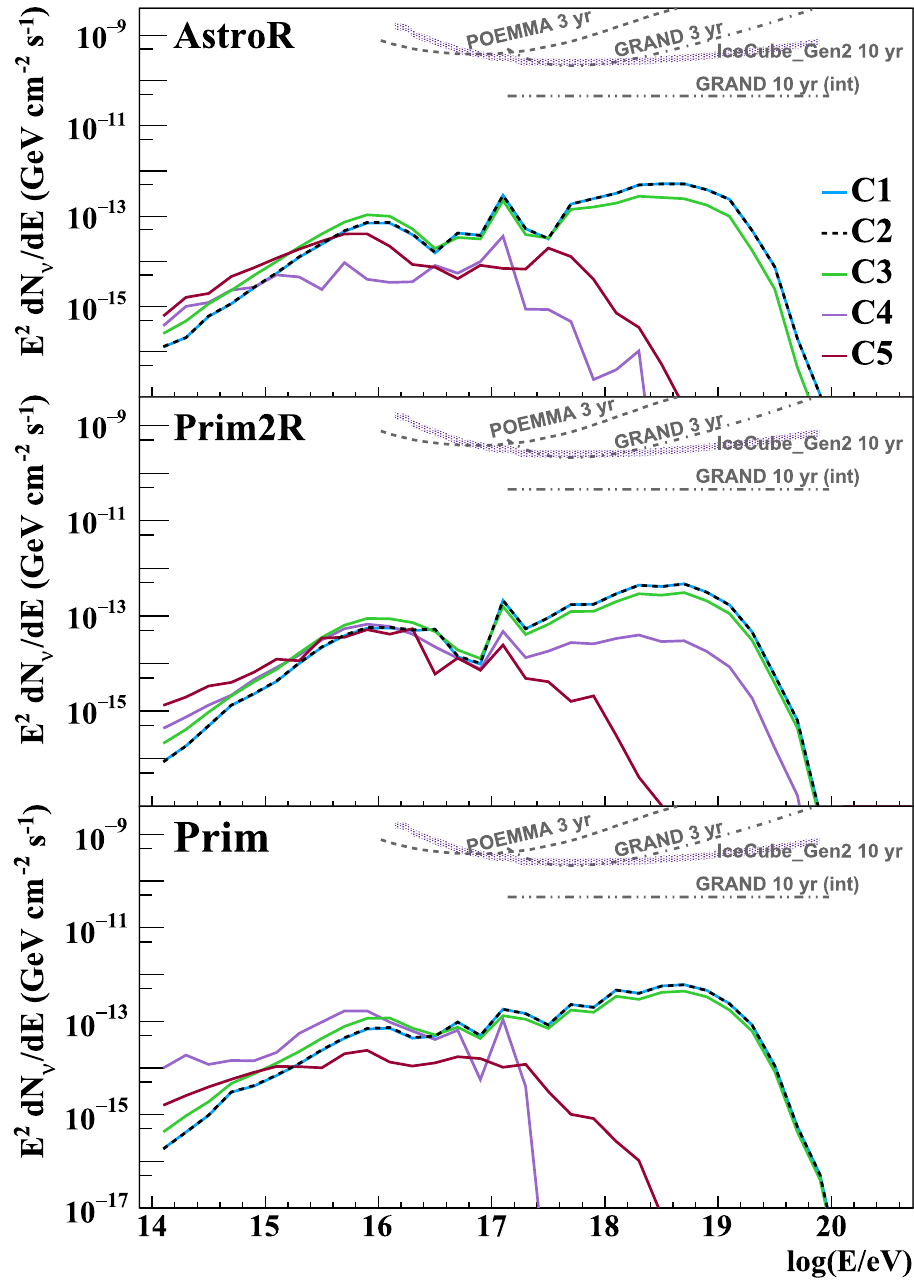
Fig. 4 Flux of secondary neutrino as a function of energy. Three EGMF are shown: AstroR, Prim2R and Prim. Each curve corresponds to a composition abundance: C1–C5. The sensitivity of future experiments POEMMA [20] and GRAND